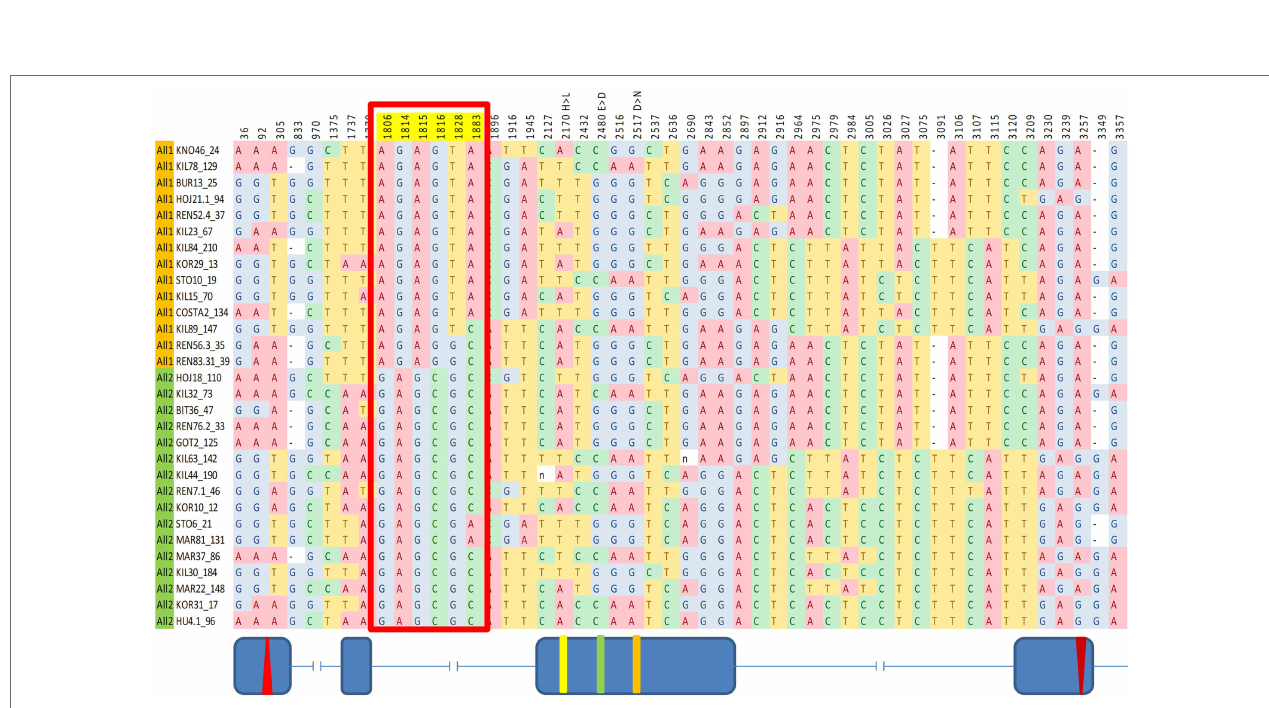
FIGURE 4 | Fine mapping of SNPs in cry associated with circadian acrophase. The red box indicates six SNPs showing a significant association. Fly strains are organized accordingly to two haplotype groups (All1, orange; All2, green). These SNPs form a linkage group within intron II. Schematic diagram (not to scale) indicating the exon–intron is shown below.